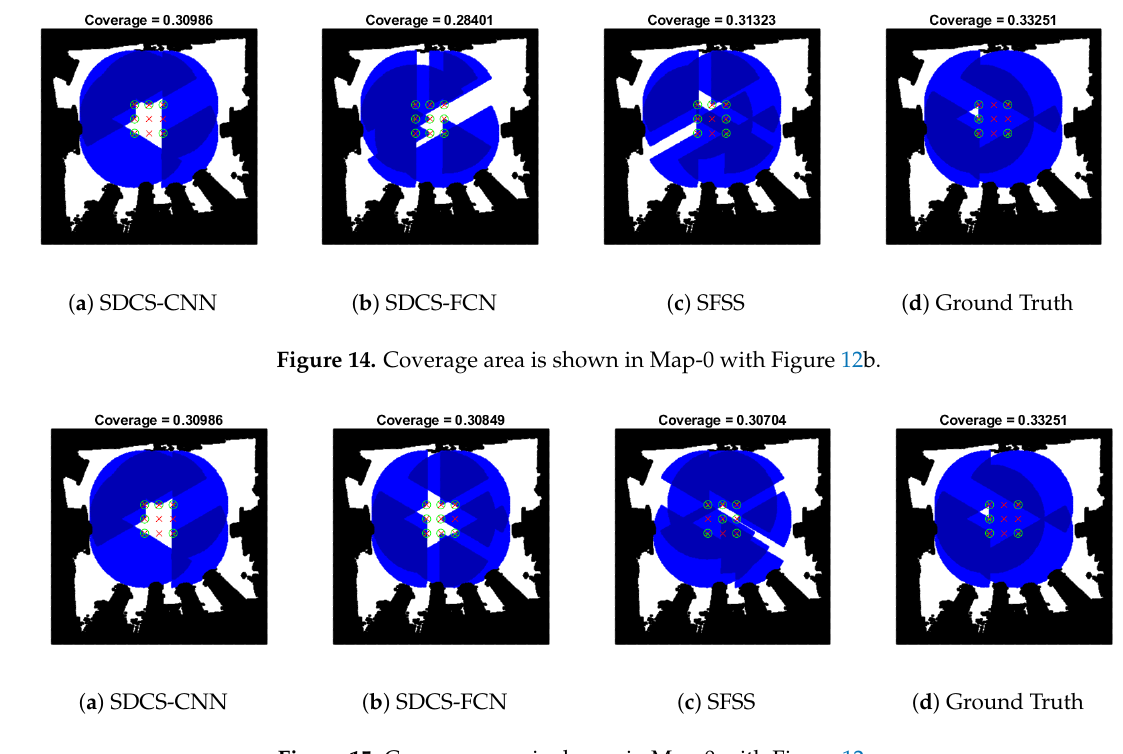
Figure 15. Coverage area is shown in Map-0 with Figure